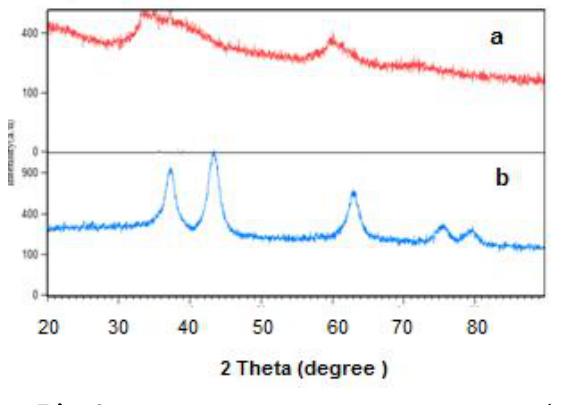
Fig. 2 . X-ray pattern of NiO nanoparticle (a) before and (b) after calcination.